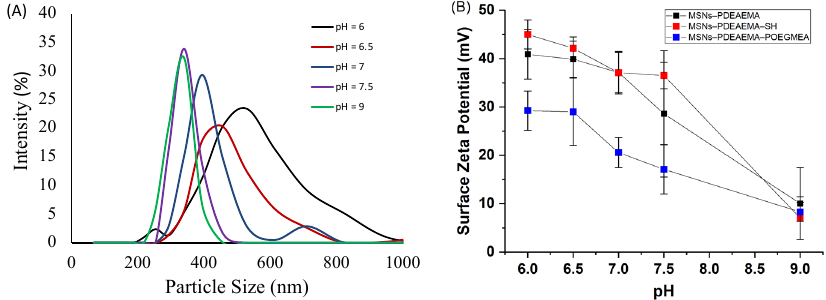
Figure 5. ( A ) Size distribution at different pH values of MSNs–PDEAEMA. ( B ) Zeta potential values at